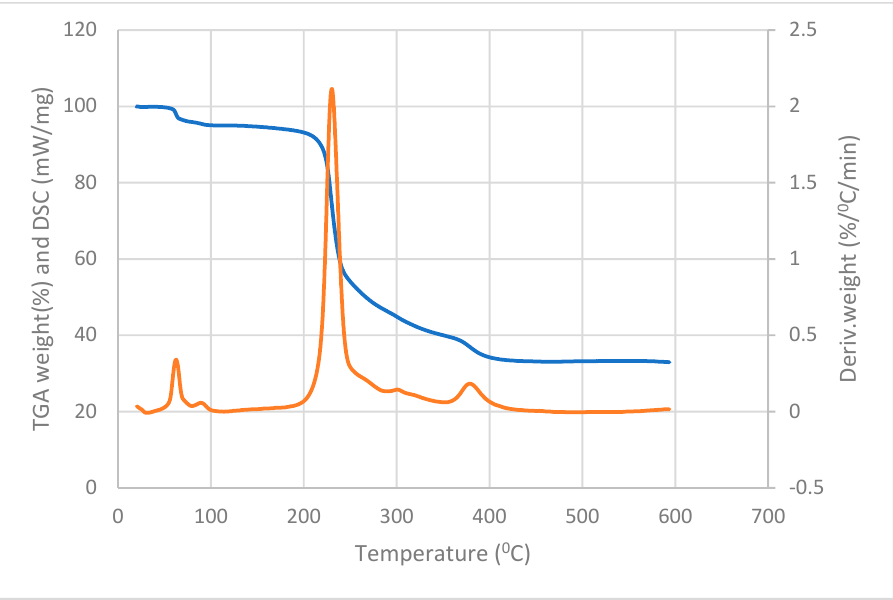
Figure 7. TGA and DSC plot of copper (II) N -methyl- N -phenyl dithiocarbamate complex. The blue color is the TGA plot while the orange color is the DSC plot.